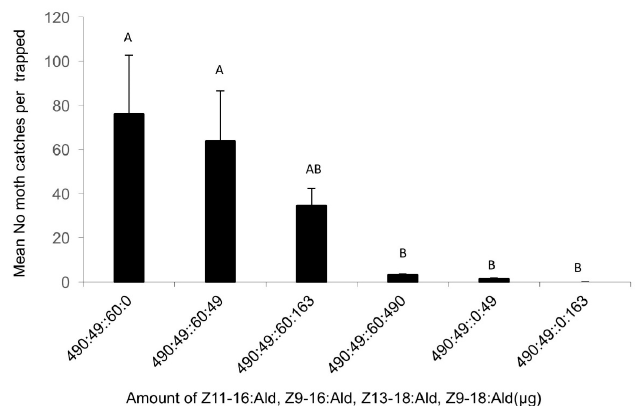
Figure 6. The average number of male Chilo suppressalis moths caught per trap per night in the rice fields in Ningbo, Zhejiang (3 June–29 June 2013), by lures made up of mixed blends of the pheromone components Z11-16:Ald, Z9-16:Ald, Z13-18:Ald, Z9-18:Ald, in the ratios indicated along the x axis. Each treatment was replicated five times. Treatment bars represent the standard errors; bars with different letters above them are significantly different from each other in the number of male moths captured ( p < 0.05). 3.3. Attractiveness of Synthetic Pheromone Mixtures to H. armigera in the Field The reference pheromone blend consisting of Z11-16:Ald, Z9-16:Ald, and Z13-18:Ald (490 μ g:49 μ g:60 μ g) caught a small number of H. armigera male moths in the field (Figure 7), although not as many as the blending of Z11-16:Ald and Z9-16:Ald (940:60 μ g), widely used in China for monitoring H. armigera populations. In fact, the blend of Z11-16:Ald and Z9-16:Ald (940:60 μ g) at a 1 mg dosage captured significantly more H. armigera moths than any other treatments (DF = 13, F = 7.36, p < 0.0001). The addition of 16:Ald generally increased the number of moth catches, whilst the addition of 16:Ald and 18:Ald did not significantly increase the attractiveness of the reference pheromone blend (DF = 8, F = 0.38, p = 0.9). In contrast, the addition of Z11-16:OH completely suppressed the attractiveness of the reference pheromone blend to H. armigera ; significantly fewer moths were captured when Z11- 16:OH was added to the blend of Z11-16:Ald, Z9-16:Ald, and Z13-18:Ald (490 μ g:49 μ g:60 μ g) than in any other treatments (DF = 12, F = 4.02, p = 0.0006).